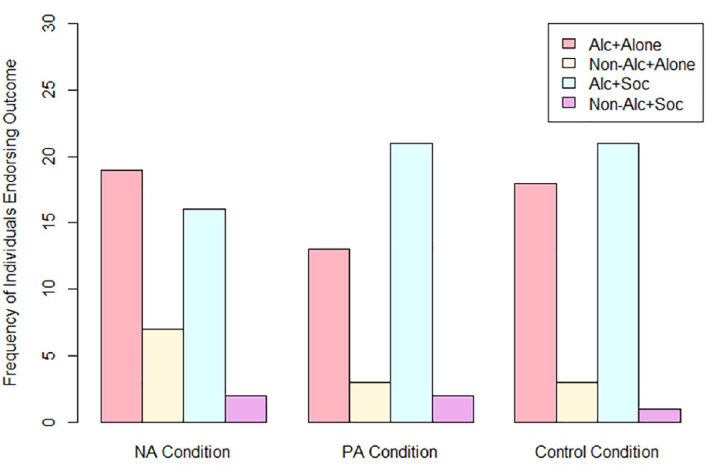
Fig 1. The number of individuals per condition who chose each of the four outcomes. Alc+Alone=choosing to drink alcohol while alone; Non-Alc+Alone=choosing to drink non-alcohol while alone; Alc+Social=choosing to drink alcohol with the ostensible other participant; Non-Alc+Social=choosing to drink non-alcohol with the ostensible other participant.